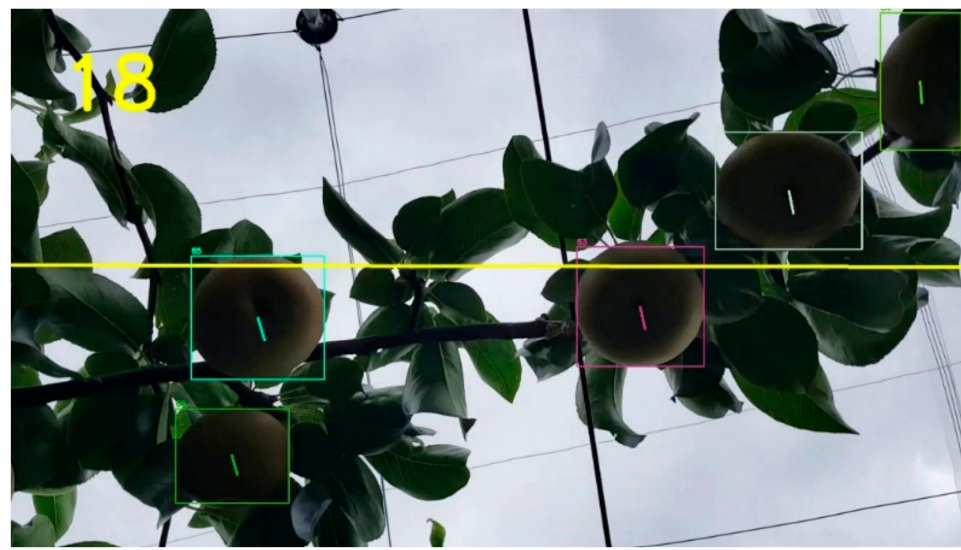
Figure 12. Pear counting system based on YOLOv4-512 and Deep SORT using the ROI-line method. The number on the top left is the number of objects that crossed the horizontal ROI line. Unique IDs can be seen on the top left corner of each bounding